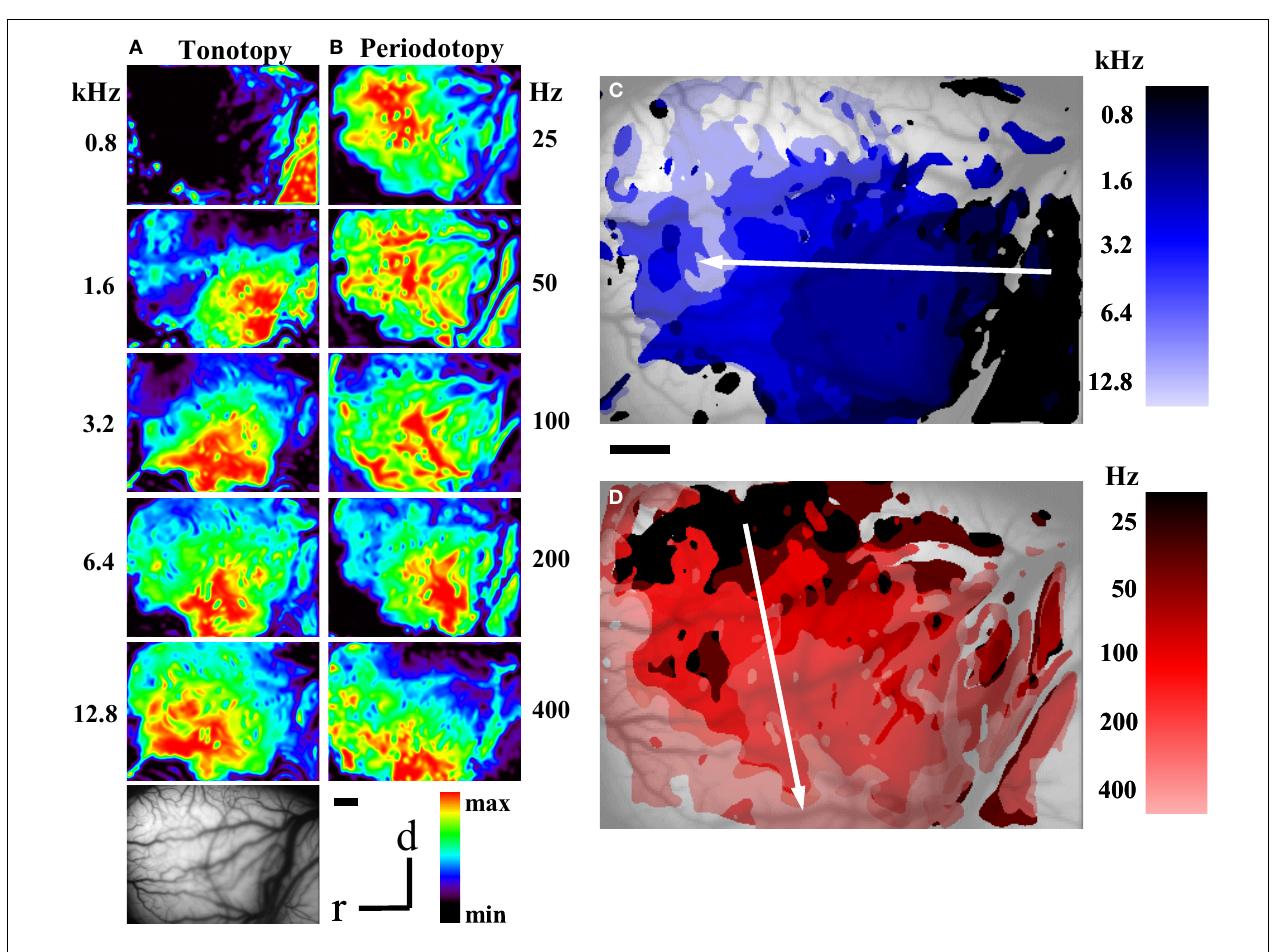
FIGURE 2 | Optical imaging of intrinsic signals in cat auditory cortex after stimulation with pure tones and harmonic sounds. (A) Single condition maps for stimulation with pure tone bursts of 0.8 to 12.8 kHz as indicated. Sound intensity was 40 dB SPL. Bar length is 1 mm. Warm colors show regions of refl ectance changes, indicating enhanced cortical activation. Each single condition map was individually scaled to its maximal refl ectance change. The full color scale corresponds to fractional refl ectance changes of maximal 4.9 × 10 − 2 . There is a shift of the areas of refl ectance changes from caudal to rostral when the frequency of stimulation is increased, indicating the tonotopic or cochleotopic gradient. (B) Single condition maps for stimulation with harmonic sounds with harmonics covering the frequency range from 0.4 to 4.8 kHz and different fundamental frequencies between 25 and 400 Hz, as indicated. In order to have a constant bandwidth the lowest component of these stimuli were kept at 400 Hz and higher fundamentals were excluded. Same animal as in Figure 2A . Sound intensity was 40 dB SPL. Conventions as in (A) . Compared to